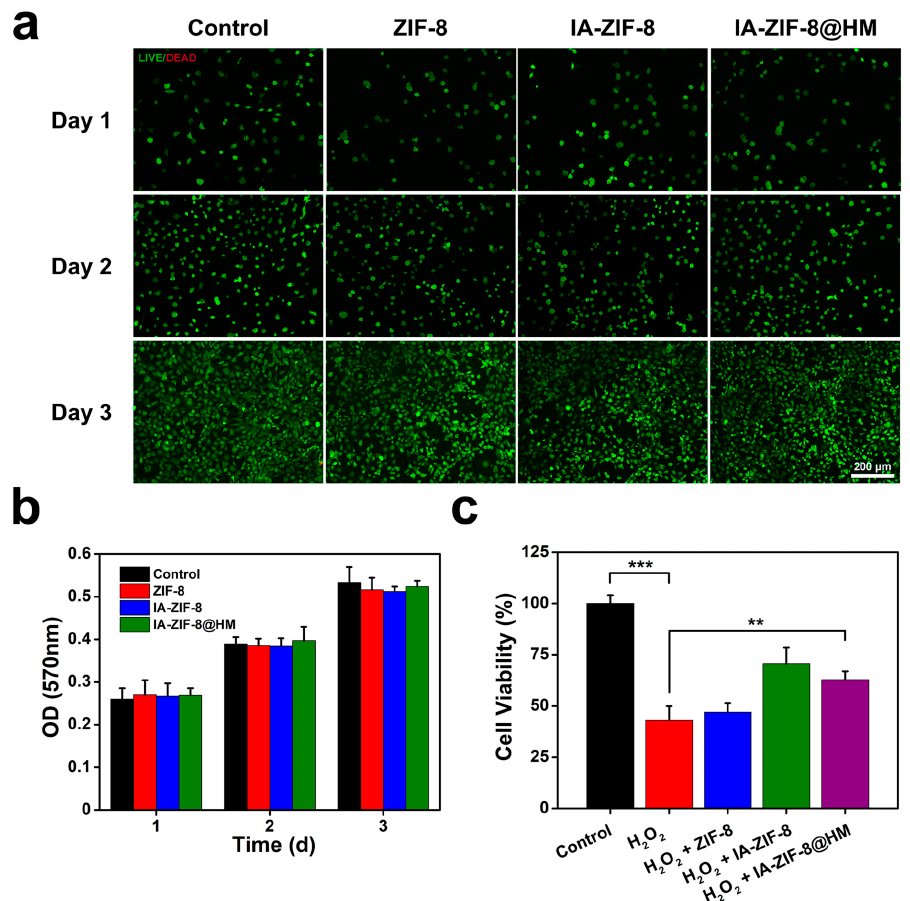
Figure 2. In vitro cytotoxicity and anti-oxidative stress effects of composites. ( a ) The live/dead fluorescence results of control, ZIF-8, IA-ZIF-8, and IA-ZIF-8@HM groups on 1, 2, and 3 days. ( b ) In vitro cytotoxicity of ZIF-8, IA-ZIF-8, and IA-ZIF-8@HM groups on ATDC5 cells detected by MTT assay. ( c ) The results of cell viability about chondrocyte co-cultured with H 2 O 2 , H 2 O 2 + ZIF-8, H 2 O 2 + IA-ZIF-8, and H 2 O 2 + IA-ZIF-8@HM (** p < 0.01, *** p < 0.001).